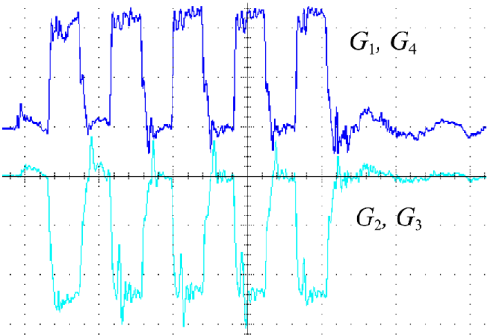
Figure 13. Waveforms of the MOSFET driving signals (100 nS/div 5 V/div).